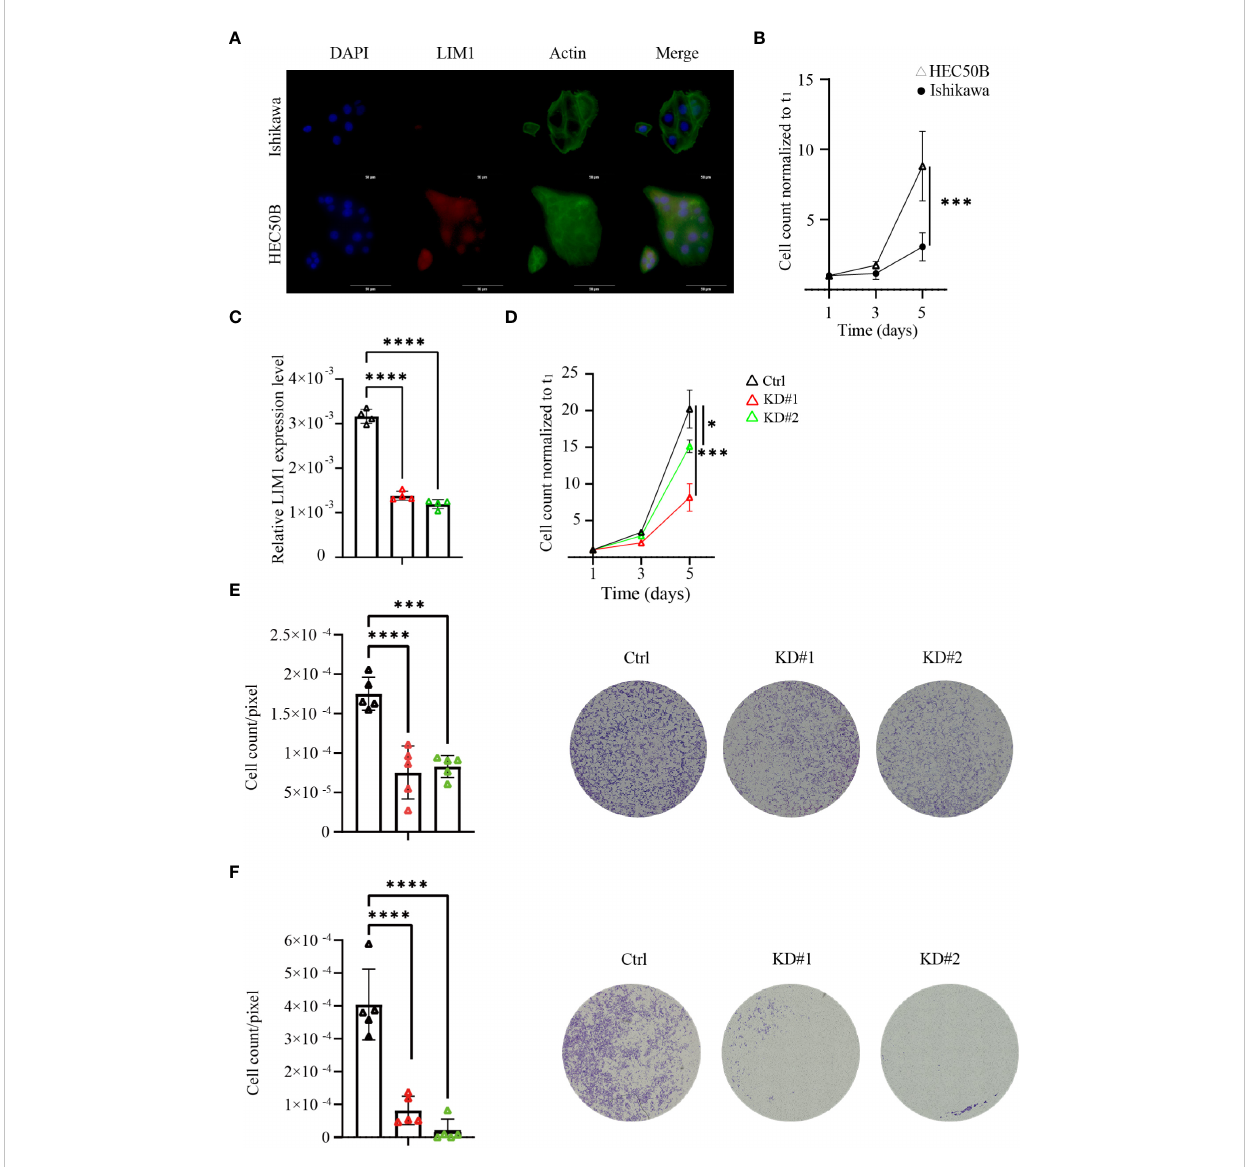
FIGURE 3 LIM1 knockdown (KD) in EC inhibited cell proliferation and invasion in vitro . (A) Immunocytochemical staining of LIM1 and phalloidin-actin staining in EC cells representing two different grades, i.e., Ishikawa cells and HEC50B cells. Red: LIM1, blue: nucleus, green: F-actin. Scale bar: 50 m m. (B) Cell counts to assess cell proliferation in Ishikawa cells and HEC50B cells (n = 3, Student ’ s t- tests). (C) RT-qPCR for LIM1 using HEC50B cells treated with shControl (Ctrl) and shLIM1 (KD#1 and KD#2; n = 4, one-way ANOVA). (D) Cell counts to assess cell proliferation in Ctrl and KD sublines (n = 4, one-way ANOVA). (E) Migration assays using Transwells in Ctrl and KD sublines (n = 5, one-way ANOVA). Representative photographs are shown in the right panels. Scale bar: 50 m m. (F) Invasion assays using an extracellular matrix in Ctrl and KD sublines (n = 5, one-way ANOVA). Representative photographs are shown in the right panels. Scale bar: 50 m m. * p < 0.05, *** p < 0.001, **** p < 0.0001. Graphs show means ± standard